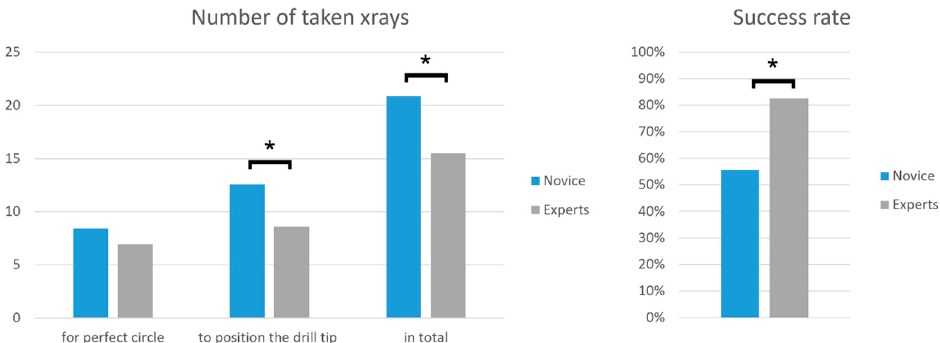
Figure 4. Results from the questionnaire of all participants. 1: “absolute not realistic”; 7 “perfectly realistic”.